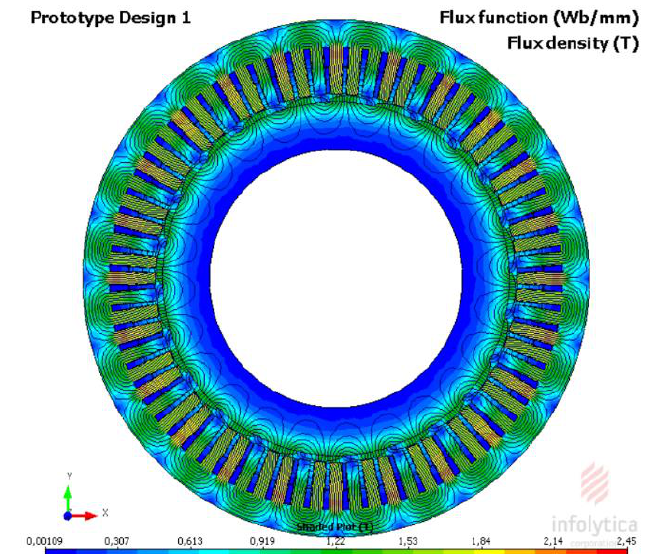
Figure 1. Distribution of electromagnetic